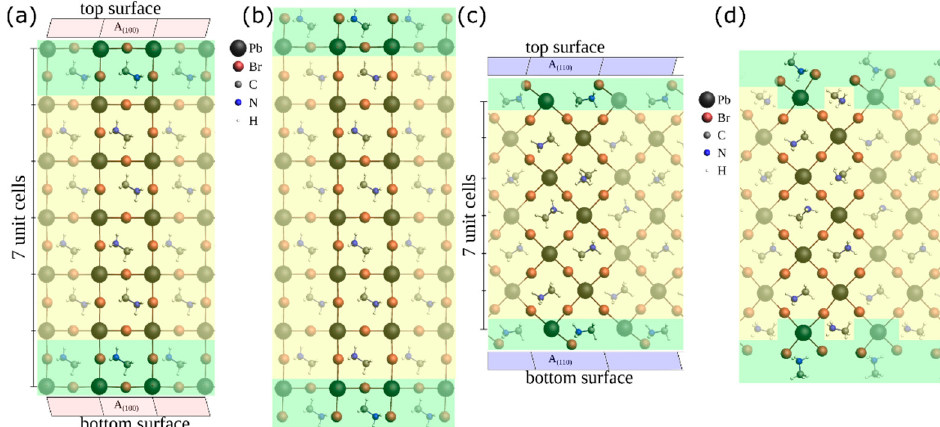
Figure 7. Four types of slabs with lateral periodic boundary conditions (pbc) with (100)-surfaces on the left and (110)-surfaces on the right (Transparent atoms indicating the periodically continued supercells; view along the y-axis). The surface region is marked with a green background and the inner region with a yellow background. The (100)-surface can be terminated by a ( a ) PbBr 2 -layer or by a ( b ) MABr-layer. The (110)-surface can be terminated by a ( c ) mixed layer or by ( d ) MABr-molecules 2 which lead to a two-fold excess of MABr. The (100)-slabs have an area A ( 100 ) = 35.105 Å and the 2 (110)-slabs have an area of A ( 110 ) = 49.649 Å each on the top and on the bottom